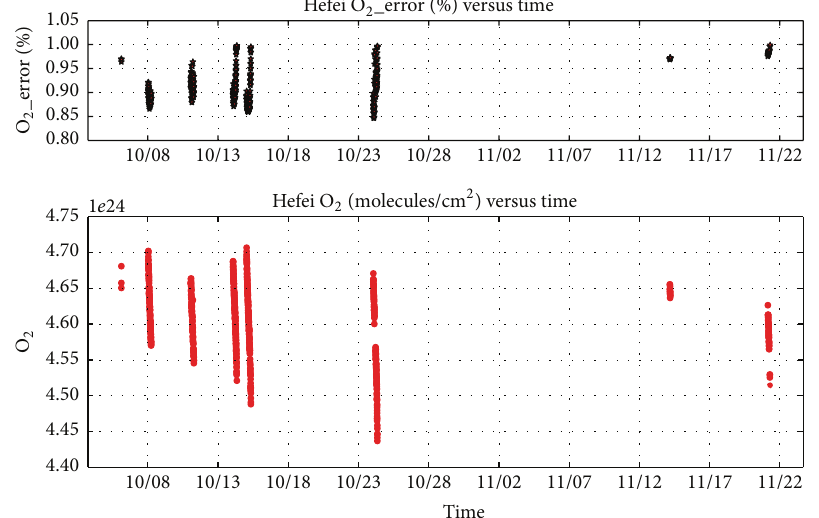
Figure 7: VCD time series ranging from October 6, 2014, to December 1, 2014, which are the retrieval values in 7885 cm −1 window. O 2